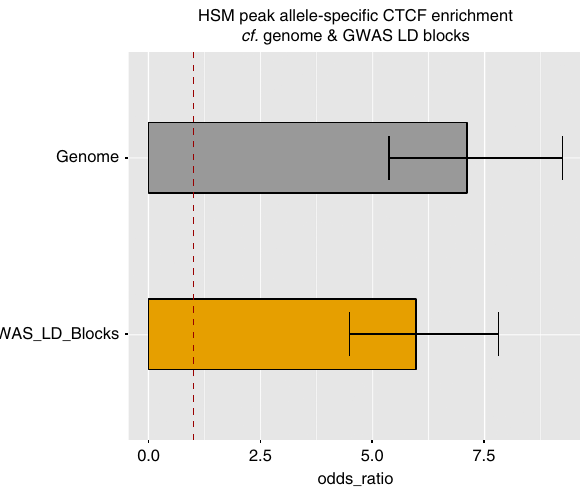
Fig. 9 Allele-speci fi c CTCF enrichment. Allele-speci fi c CTCF (AS-CTCF) enrichment in HSM peaks compared to the genome and GWAS LD block regions. The AS-CTCF data is derived from Ding et al. 41 , which identi fi ed common human variants acting as quantitative trait loci (QTLs) that in fl uenced binding in ChIP-seq CTCF data. Fisher ’ s exact test both p < 2.2 × 10 − 16 , compared to genome and LD blocks, odds ratio (OR) = 7.12 and 5.98, respectively. Error bars indicate 95% con fi dence intervals, dotted red line is OR = 1